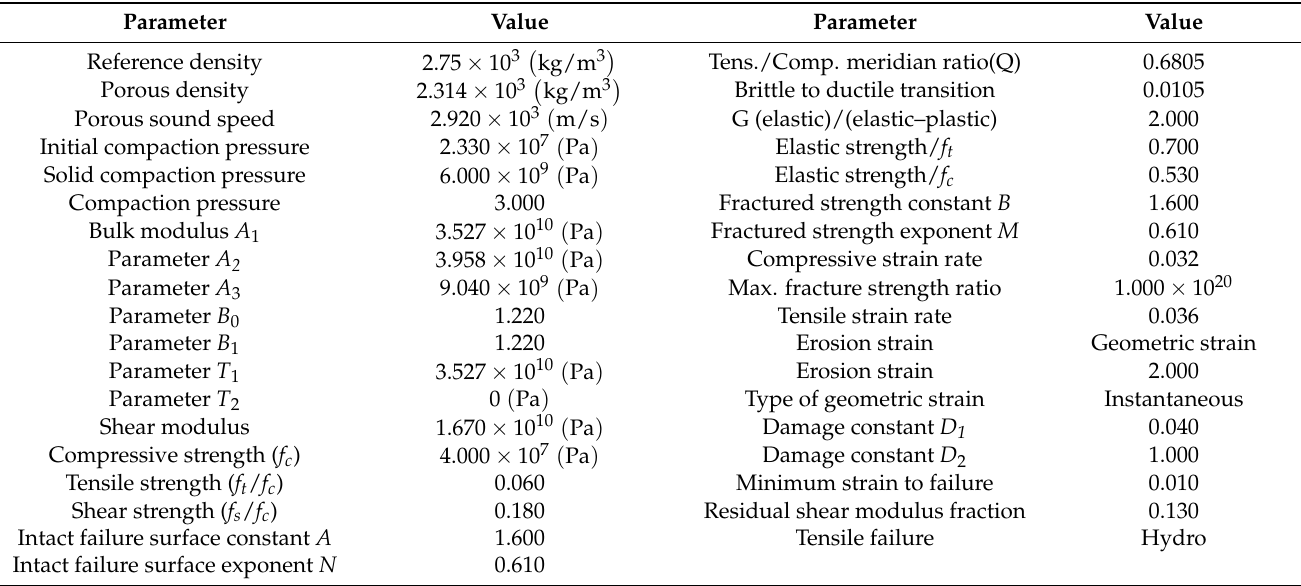
Table 2. Parameters of RHT model for